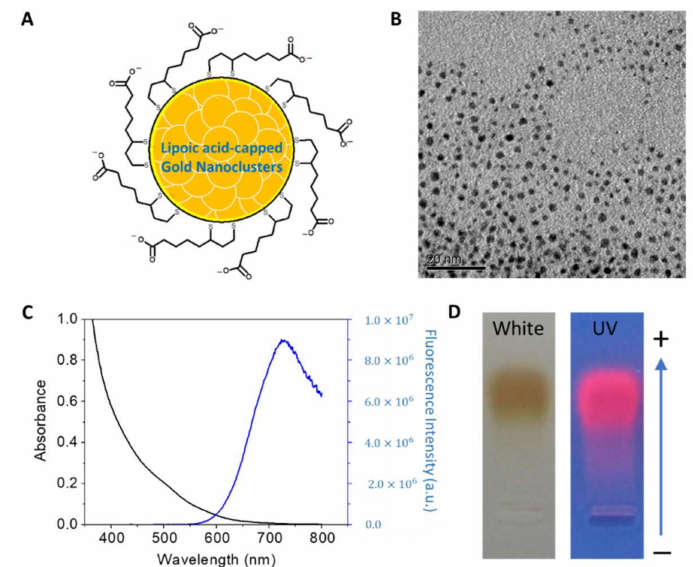
Figure 3. Characterization of gold nanoparticles (AuNPs). ( A ) Illustration of lipoic acid-capped AuNPs containing tens of Au atoms per nanoclusters; ( B ) TEM image of AuNP-DHLA (scale = 20 nm); ( C ) UV-Vis absorption spectra (black line) and emission spectra (blue line, excitation at 490 nm) of AuNP-DHLA; ( D ) Gel electrophoresis photograph of AuNPs in 2% agarose gels under white light and UV light exposure ( λ ex = 365